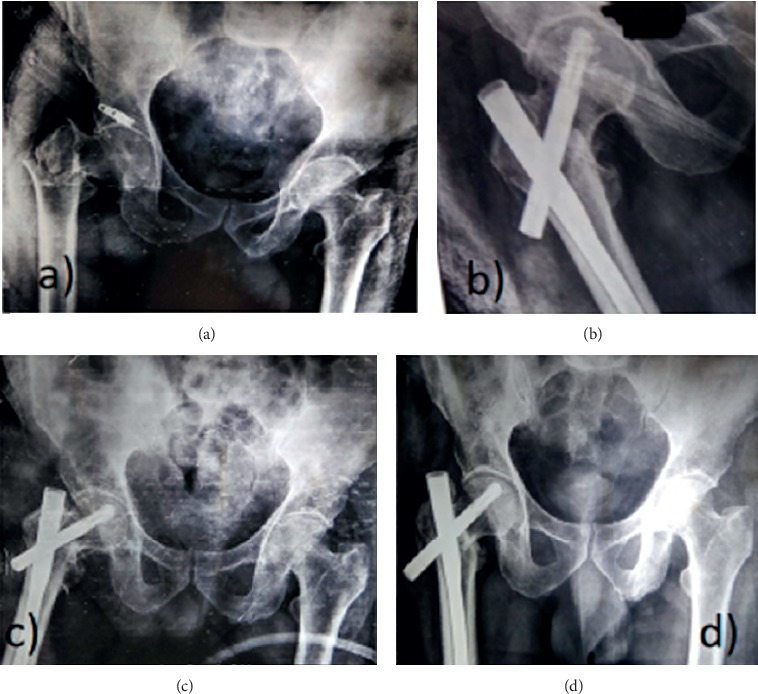
(a) Preoperative X-ray. (b) Immediate postoperative X-ray with lateral entry showing varus reduction, (c) at 6 weeks and (d) at final follow-up showing screw back out.